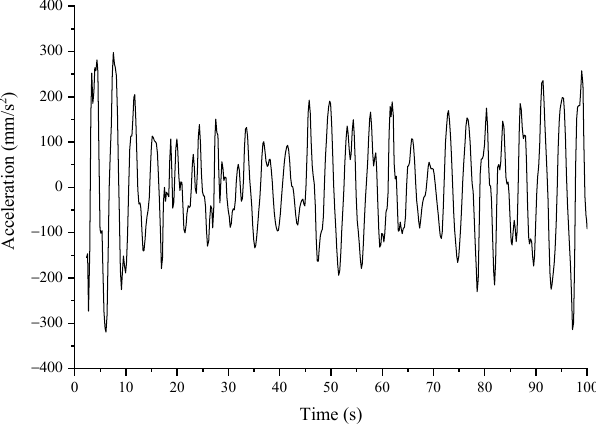
Figure 17. Response accelerations of the hub under resonant ice conditions (ice thickness was 0.32 m and ice velocity was 0.63 m·s − 1 ).